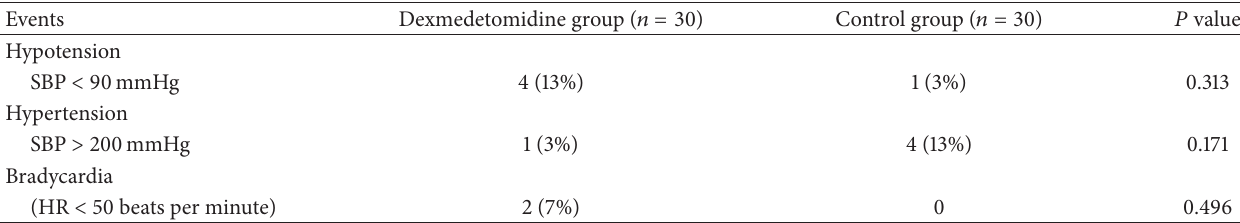
Table 4: Incidence of adverse effects during and after